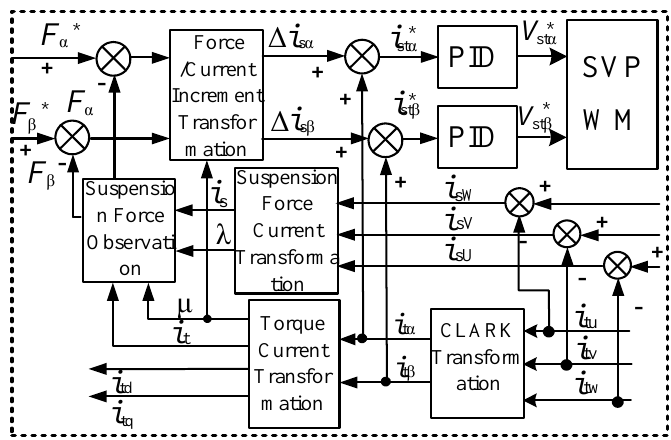
Figure 9. Block diagram of the suspension force vector control.